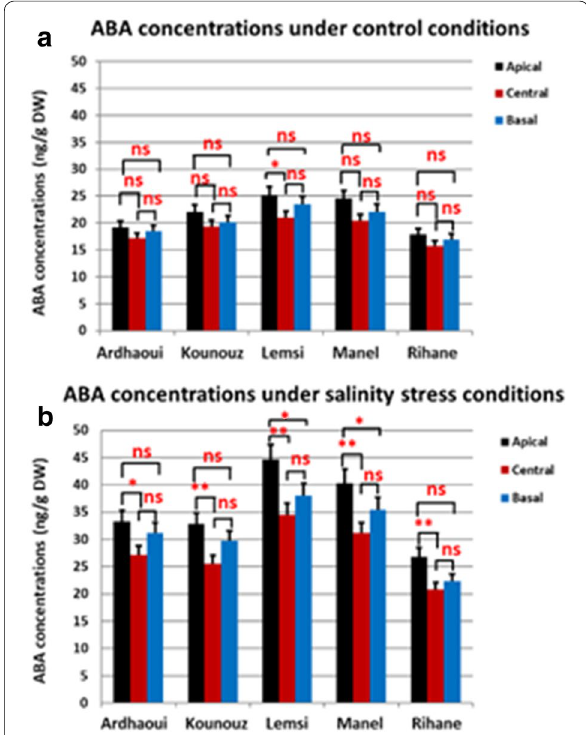
Fig. 5 ABA concentrations (ng/g DW) in apical, central and basal spike sections at green anther stage of the five spring barley genotypes under control ( a ) and salinity stress ( b ) conditions. *Significant ( P < 0.05%). **High significant ( P < 0.01). ‘ns’ 0 non-significant. Significant differences among the genotypes and the spike sections has been calculated using R 3.5.3